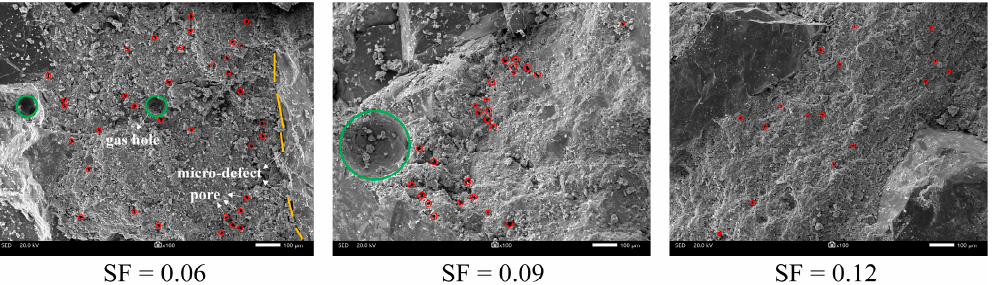
Figure 5. The internal microscopic characteristics of different SF magnified 100 times.